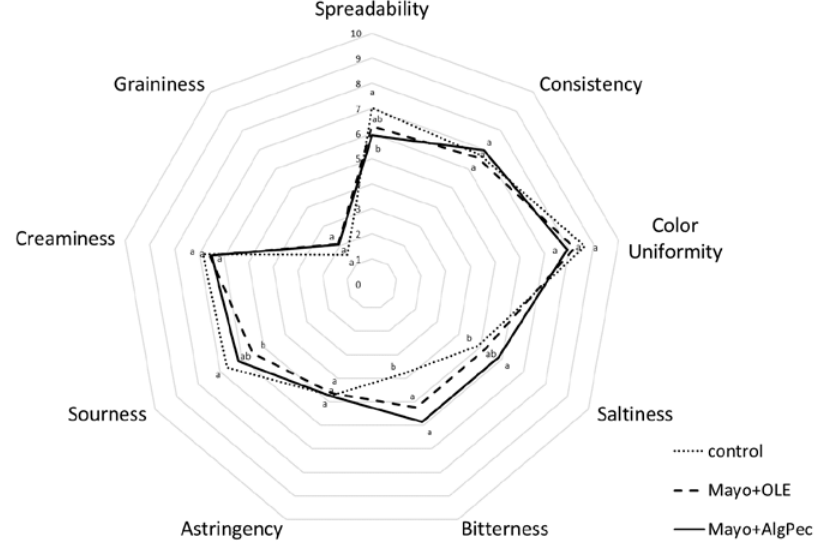
Figure 6. Spider plot of specific sensory attributes of the mayonnaise formulations. Lowercase letters for each attribute indicate significant differences ( p < 0.05).